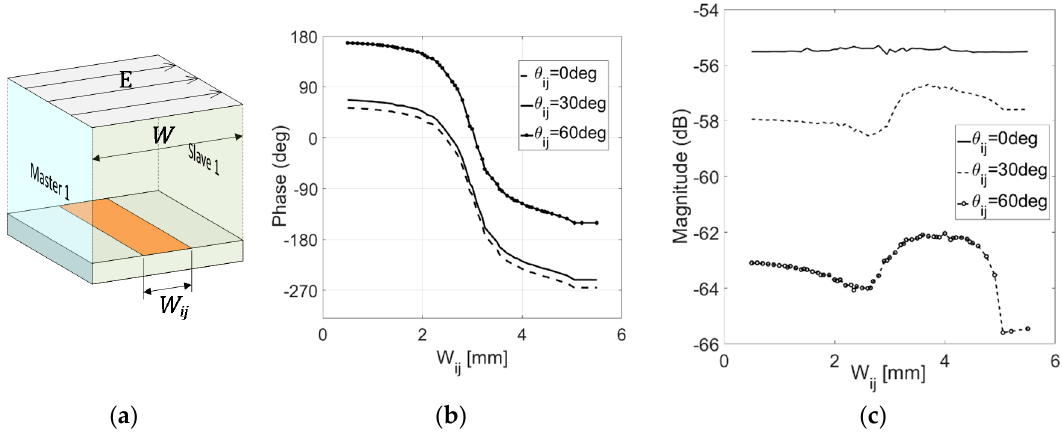
Figure 2. Single cell characterization at 20 GHz: ( a ) Simulation model of an elementary cell large W = λ /3 (where λ is computed at 20 GHz); ( b ) phase of the reflected field for different angles of incidence; ( c ) amplitude of the reflected field.